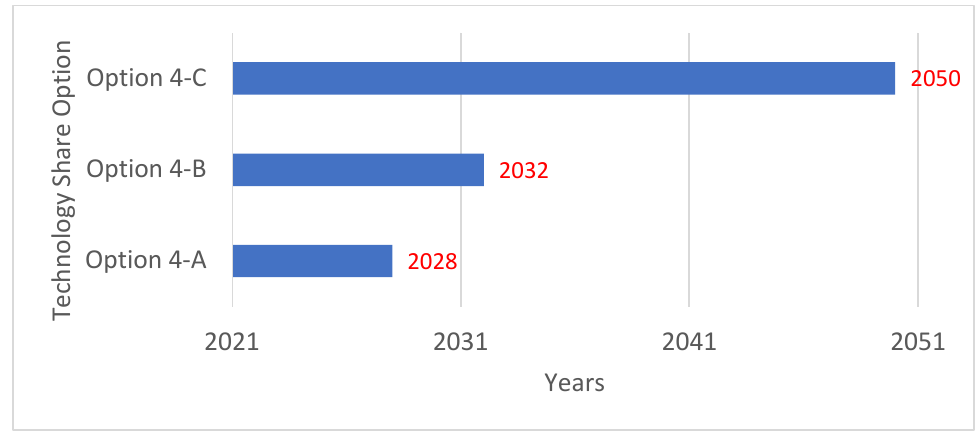
Figure 4. The timeline for technologies to achieve electricity demand and net-zero GHG emissions.